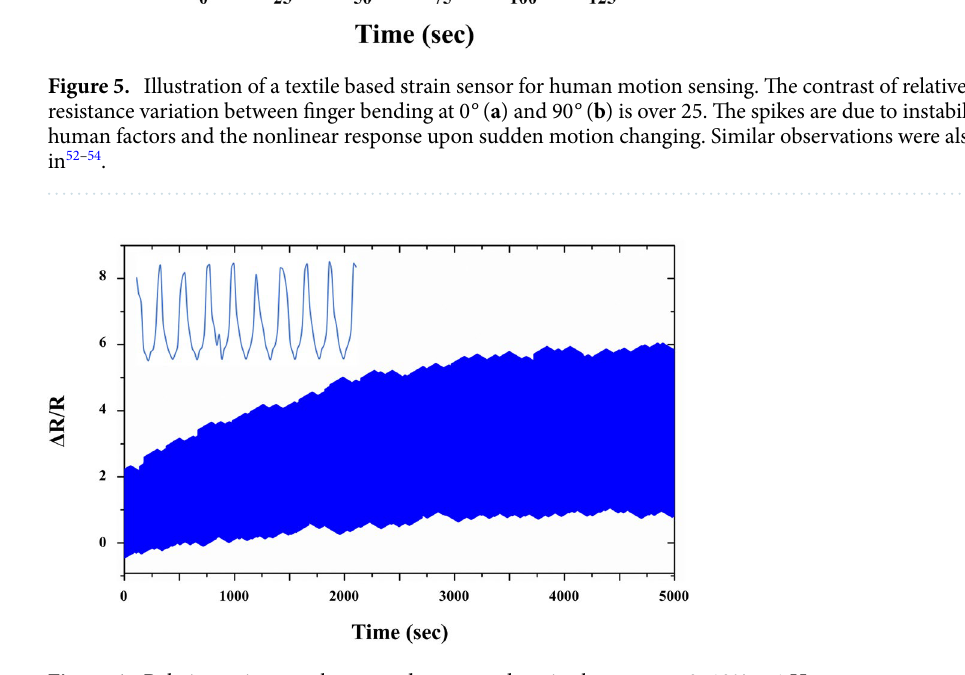
Figure 6. Relative resistance change under repeated strains between ε = 0–10% at 1